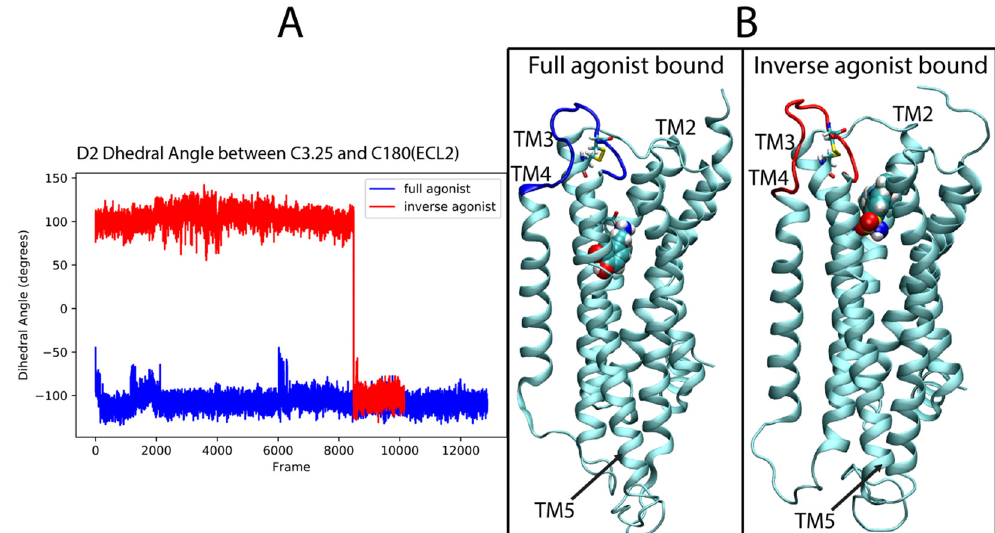
Figure 11. Involvement of residue C182 identified by the D2R sensitivity analysis in the discrimination of ECL2 structures. ( A ) The dihedral angle is measured along the disulfide bond between C182 and C3.25 for the full agonist-bound (blue) and inverse agonist-bound (red) trajectories. ( B ) Illustrative frames from the trajectories in panel A representing the two dihedral angle states. The ligand for each function class (Dopamine for full agonist, and Sulpiride for the inverse agonist) is shown in colored CPK.